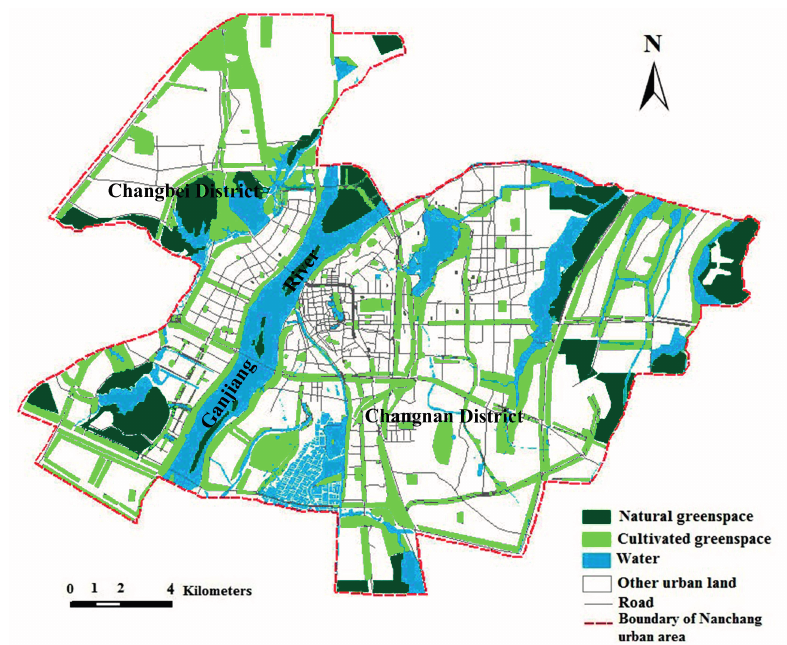
Figure 2. Urban green space system planning map of Nanchang in